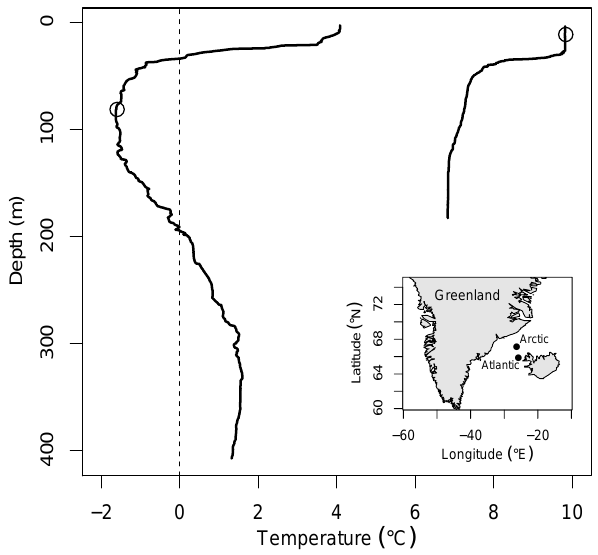
Figure 1. Temperature profiles at the Atlantic and Arctic sampling sites. Seawater for 32-day incubations was collected at 10 and 80m depth at the Atlantic and Arctic stations, respectively (indicated by